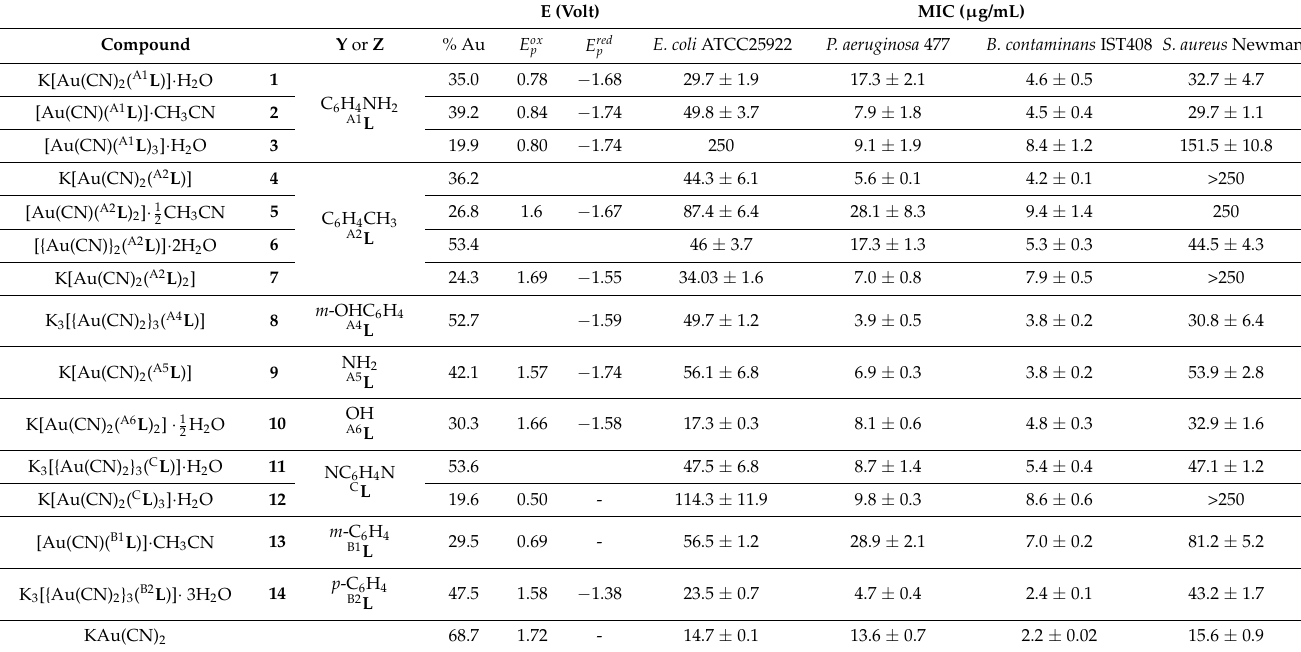
Table 1. Biological and cyclic voltammetry data a for Au(I) complexes.